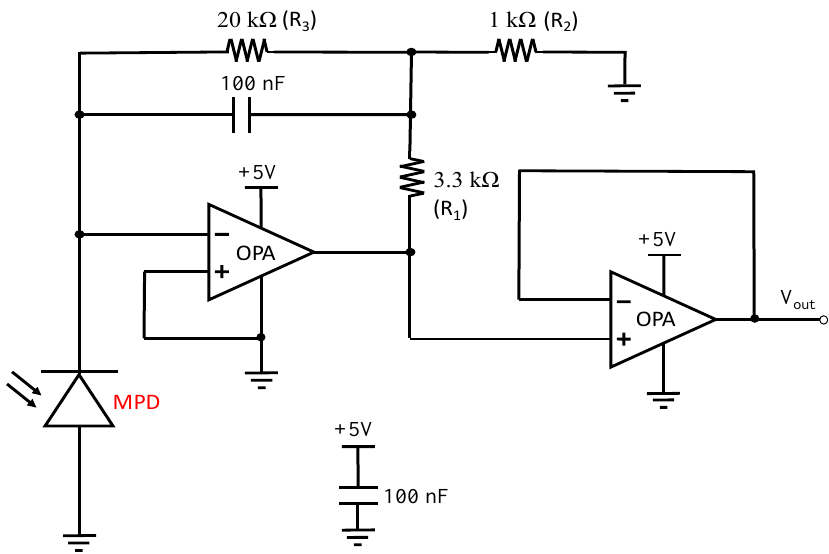
Figure 6. Schematic diagram of the MPD at zero bias, a transimpedance amplifier, and a voltage follower, where OPA represents an operational amplifier.